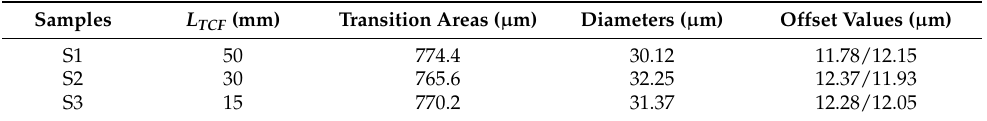
Figure 3. ( a ) Fabrication flow chart of t -TCF structure, ( b ) micro image of taper region, ( c ) transmis- sion spectra with different L TCF . Table 2. Structural parameters of the